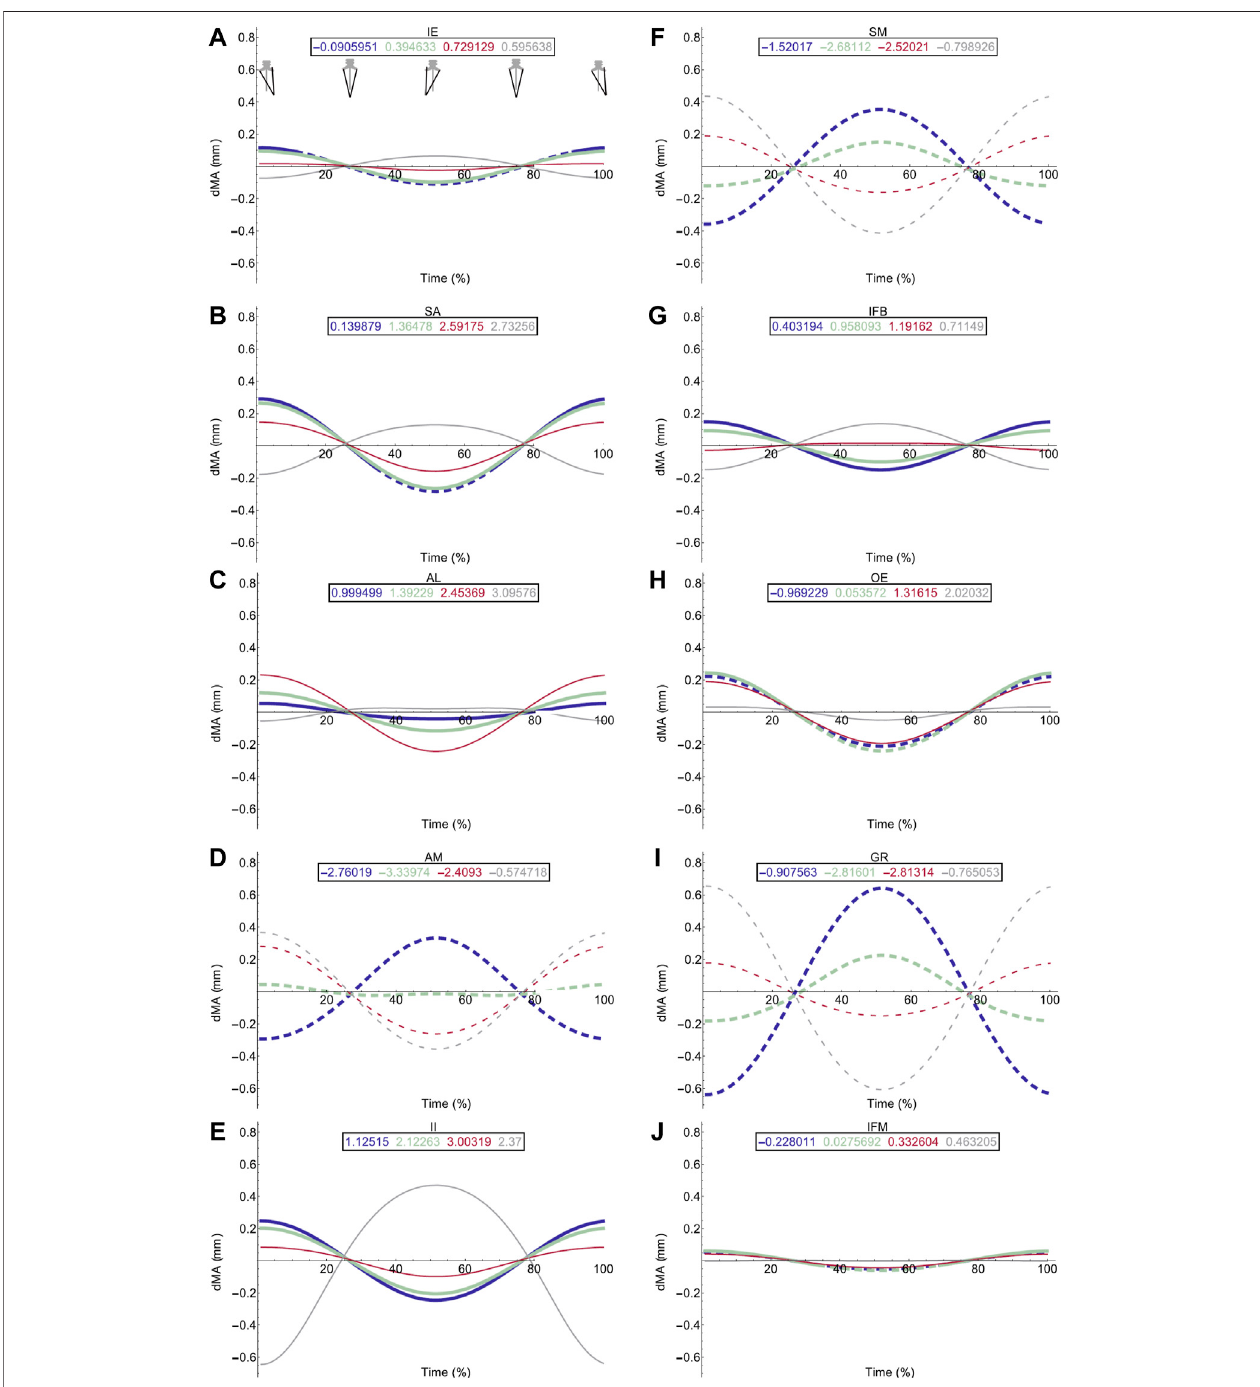
FIGURE 5 | Effect of pelvic rotation on femoral protractor and retractor muscle moment arms. Changes in fl exion/extension moment arm (dMA) versus time are shownforprotractormuscles (A – E) ;Iliacusexternus,IE, (A) ,sartorius,SA (B) ,adductorlongus,AL, (C) ,adductormagnus,AM, (D) ,Iliacusinternus,II (E) andretractors (F – J) ; semimembranosus, SM (F) , ilio fi bularis, IFB (G) , obturator externus, OE (H) , gracilis minor and major, GR (I) , iliofemoralis, IFM (J) . For each muscle, four hypotheticalconditionswererun:femurheldat10 ° (blue),45 ° (lightgreen),90 ° (red)and135 ° (grey).Notethatforthesehypotheticalconditions,0 ° isde fi nedasfully retracted as seen in the null pose ( Figure 2 (E,F) such that 10 ° is near full femur retraction and 135 is near fully protracted. Solid versus dashed lines represent positive momentarms ( fl exion — femur protraction) versusnegative (extension — femur retraction) such thatachange from solidto dashed indicates achange inmuscle function.